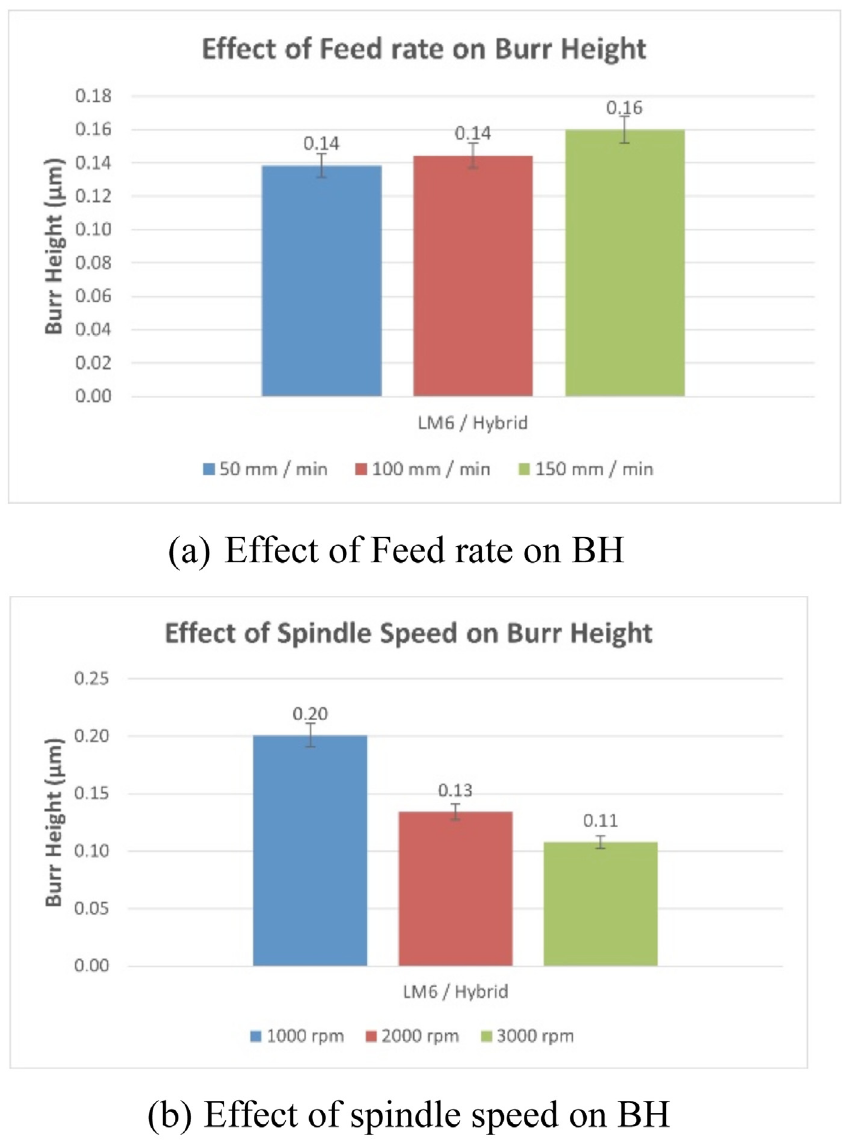
Fig. 11. (a – d) Effect of process variables on